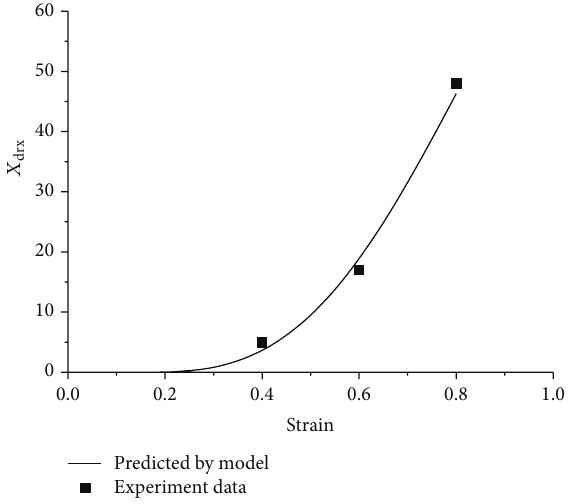
Figure 15: Comparison of the predicted value by the developed model with the experimental data.